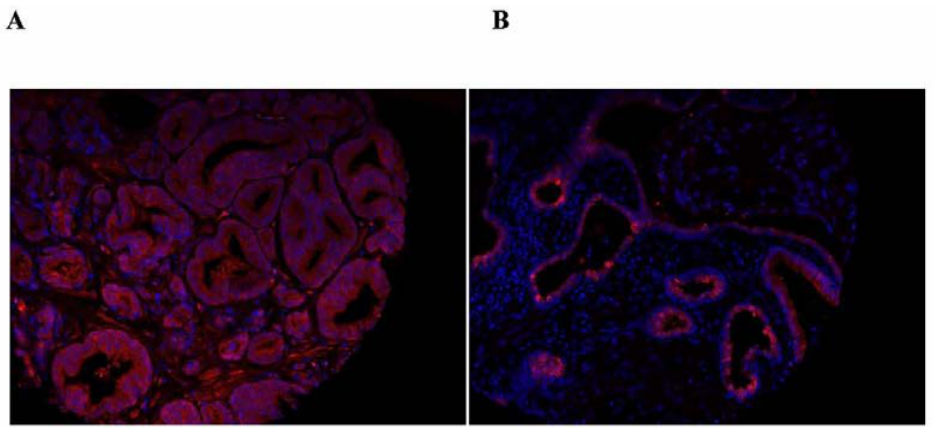
Figure 1. Samples of the images obtained upon staining human prostate tissue obtained from the outcome CPCTR tissue microarray with anti-SBP1 antibodies, shown in red. Nuclei are stained with DAPI which appears as blue. Panel A shows mostly cytoplasmic staining while panel B is an example of a tissue core that displays sporadic nuclear SBP1